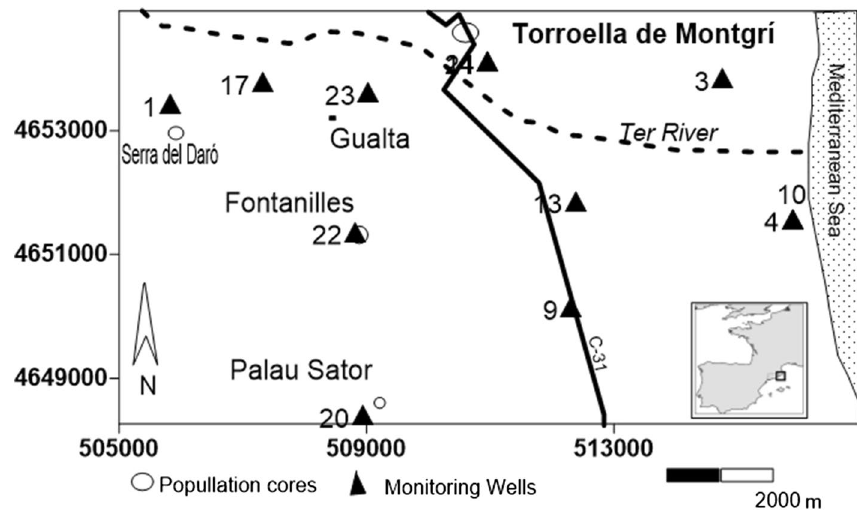
Fig. 1 Baix Emporda, Ter River delta map showing the sampling sites